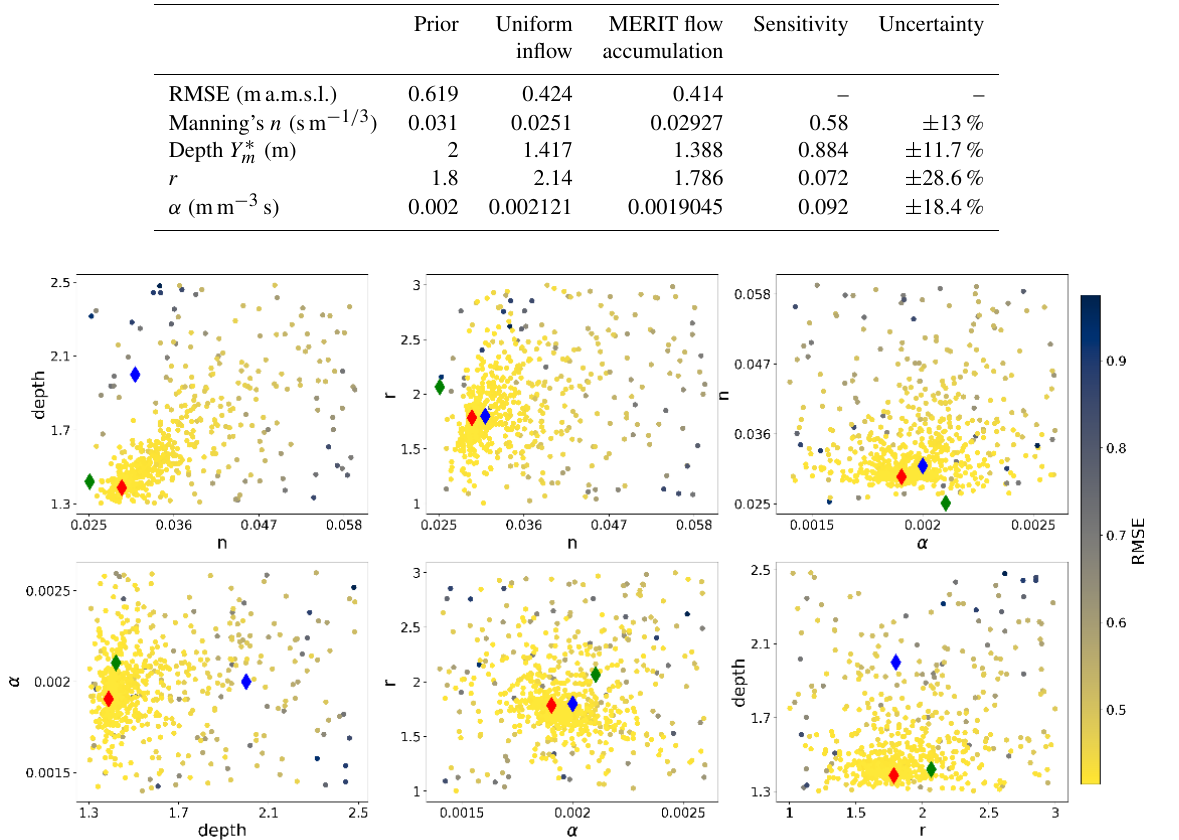
Table 1. Steady-state solver calibration results for uniform calibration values along the river stretch. The root mean square error (RMSE) is minimized. Uncertainty and sensitivity values correspond to the MERIT flow accumulation model. The sensitivity analysis is performed with FAST, and the values represent the ratio between the percent RMSE change and the percent of the parameter change. The uncertainty in the parameters is computed with the DiffeRential Evolution Adaptive Metropolis (DREAM) algorithm.